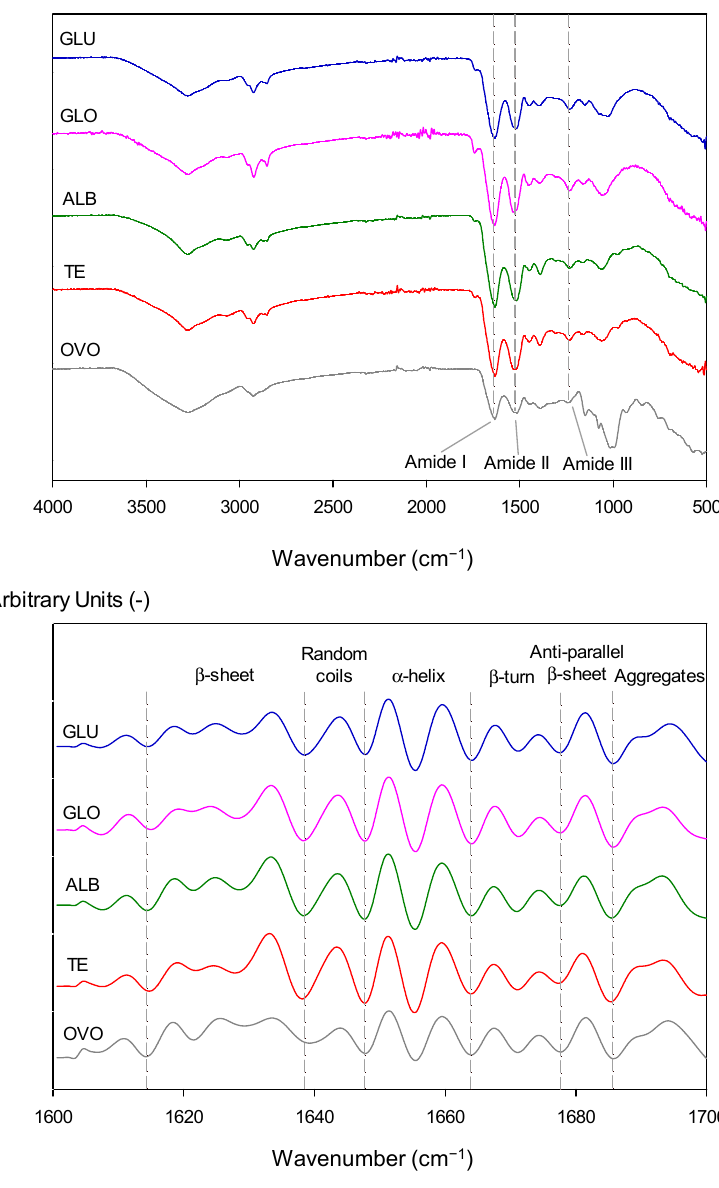
Figure 7. Fourier transform infrared spectra of ovalbumin (OVO), total extraction (TE), albumin (ALB), globulin (GLO), and glutelin (GLU). ( A ) Full spectra and ( B ) Second derivative spectrum.